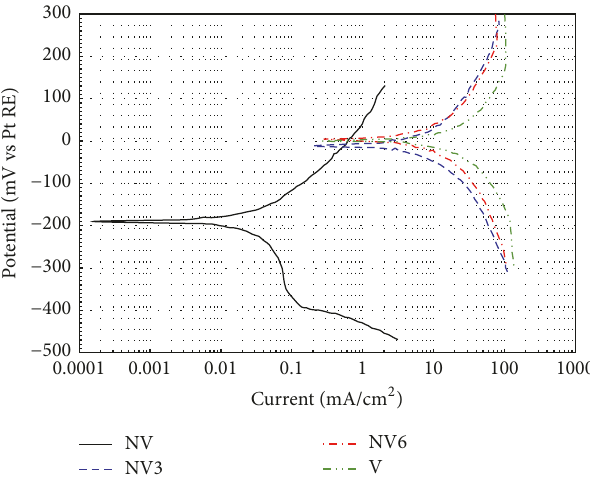
Figure 1: Potentiodynamic polarization curves for Ni in NV, NV3, NV6, and V at 700 ∘ C.